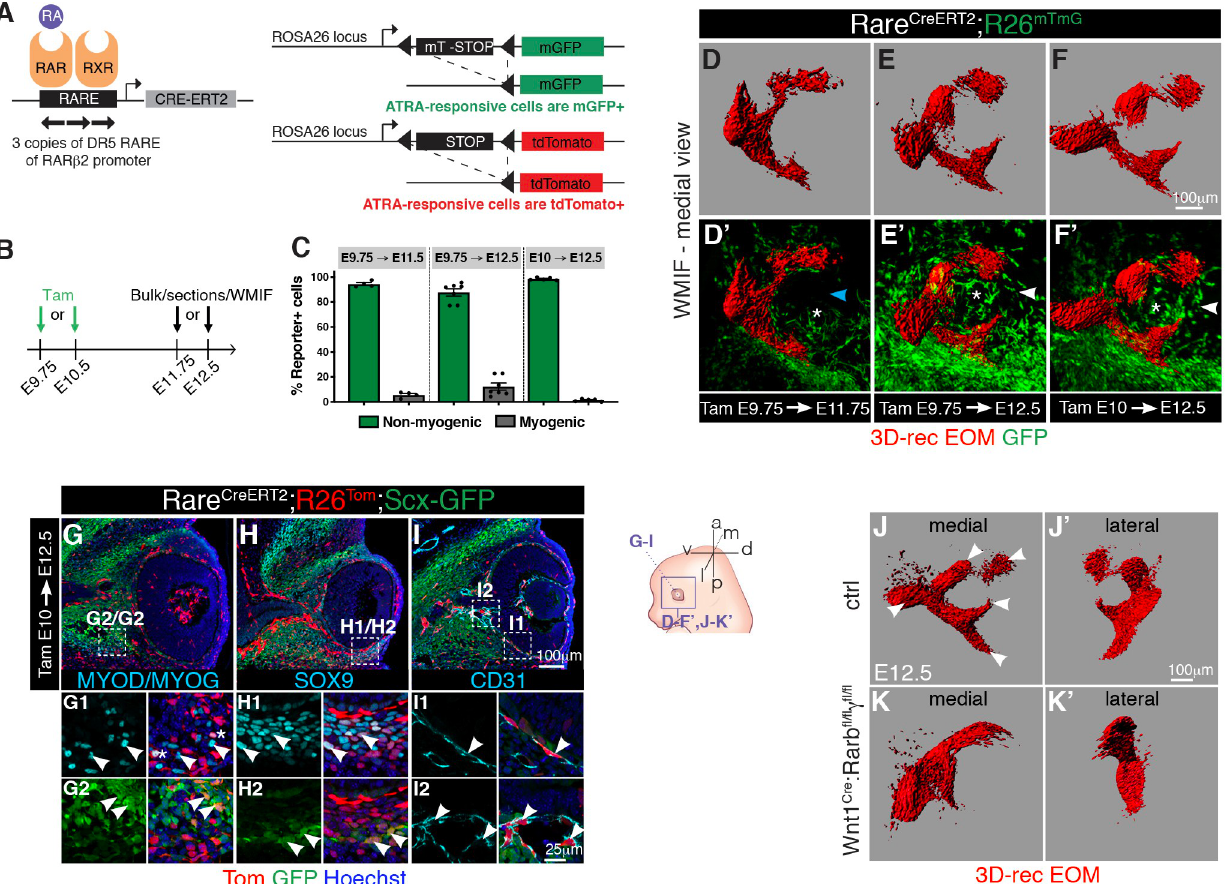
Fig 5. Periocular connective tissues are responsive to retinoic acid signaling. (A) Scheme of mouse alleles used. (B) Strategy used to determine cell types reponsive to retinoic acid signaling in Tg:RARE-CreERT2;R26 mTmG embryos. Tamoxifen was injected to pregnant females at E9.75 or E10.5 and analysis performed (bulk, sections or WMIF) at E11.75 or E12.5. (C) The percentage of recombined (GFP+) cells within the non-myogenic or myogenic populations (PAX7+, MYOD+, MYOG+) was assessed by immunostaining on bulk cell preparations of the periocular region of Tg:RARE-CreERT2; R26 mTmG embryos following different tamoxifen treatments. Each dot represents an individual embryo ( n > 4 embryos/condition). See S3 Data for individual values. (D-F’) WMIF of Tg:RARE-CreERT2;R26 mTmG embryos for SMA (differentiated muscle) and GFP (ATRA-responsive cells) at the indicated embryonic stages. The number of reporter positive cells at the place where the developing medial rectus muscle will project increases from E11.75 (blue arrowhead) to E12 (white arrowheads). Asterisks mark the optic nerve ( n = 3). (G-I) Coronal sections of E12.5 Tg:RARE-CreERT2;R26 Tom ;Scx-GFP embryos immunostained for GFP, Tom (ATRA-responsive cells), MYOD/MYOG (muscle), and CD31 (endothelial cells). Higher-magnification views as insets. Asterisks in G1 indicate sporadic labeling in myogenic cells ( n = 3). (J-K’) WMIF for MyHC (myofibers) of E12.5 control ( Tg : Wnt1Cre;Rarb fl/+ ; Rarg fl/+ ) ( J,J’ ) and mutant ( Tg : Wnt1 Cre ;Rarb fl/fl ;Rarg fl/fl ) ( K,K’ ) EOM. Medial and lateral views are shown. Note absence of splitting in mutant EOM. Arrowheads indicate split EOM in controls ( n = 2 per genotype). In D-F’ and J-K’ EOMs were segmented from adjacent head structures and 3D- reconstructed in Imaris (Bitplane). EOMs are shown as isosurfaces for clarity of visualization. a, anterior; ATRA or RA, all trans retinoic acid; ctrl, control; d, dorsal; 3D-rec, 3D-reconstruction; E, embryonic day; EOM, extraocular muscle; l, lateral; m, medial; mGFP, membrane-tagged GFP; p, posterior; RAR, retinoic acid receptor; RXR, retinoid X receptor; SMA, alpha smooth muscle actin; Tam, Tamoxifen; v, ventral; WMIF, whole-mount immunofluorescence.